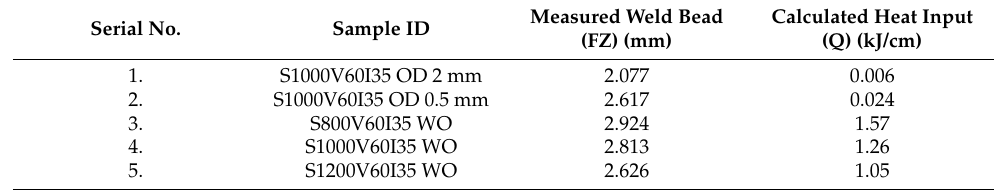
Table 3. Measured weld bead and calculated heat input comparisons for all five conditions.